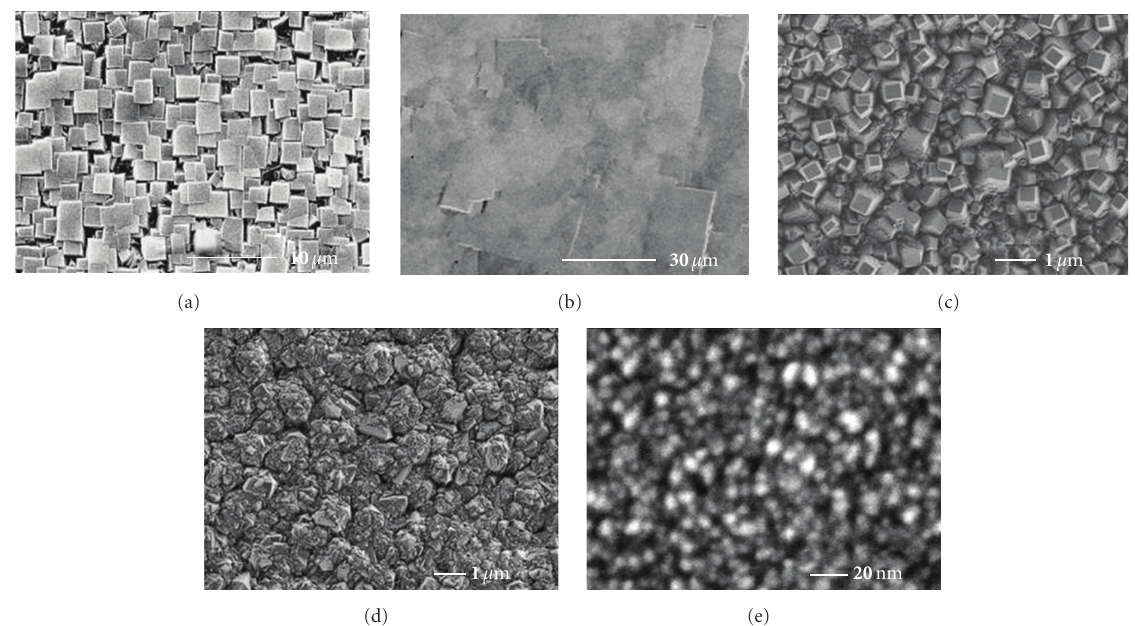
Figure 1: Plane view scanning electron micrographs of (a) epitaxial [36], (b) highly oriented (001) [37], (c) (001) oriented, (d) polycrystalline, and (e) nanocrystalline diamond thin films.